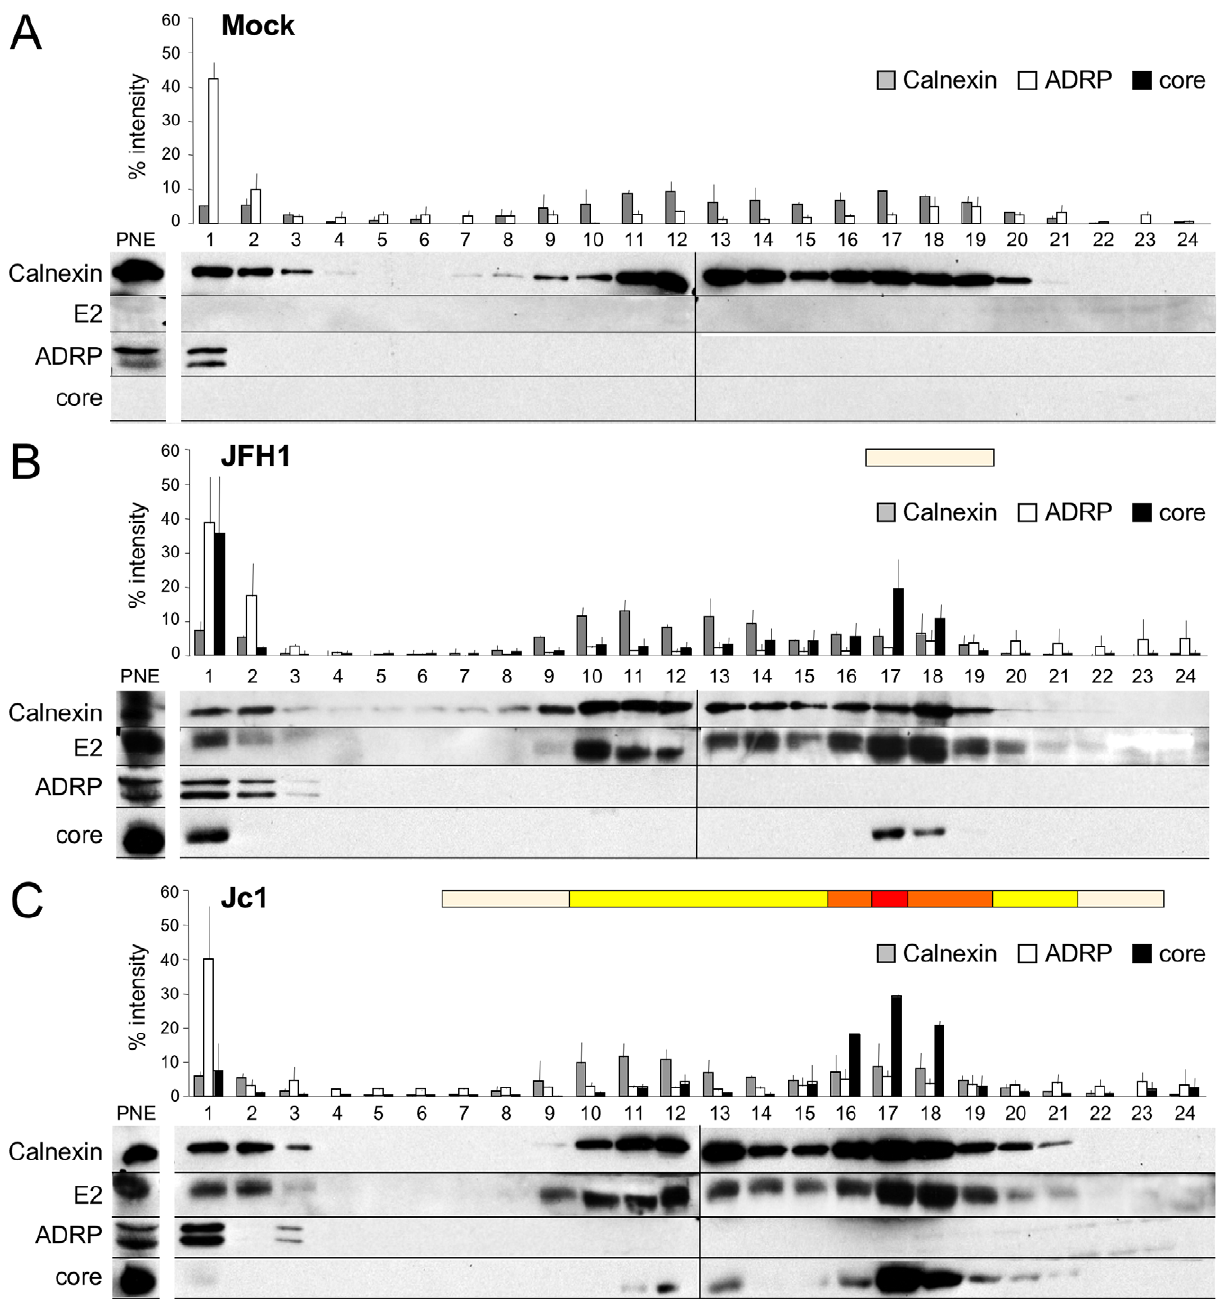
Figure 2. Characterization of JFH1 and Jc1 core localization by subcellular fractionation in HCVcc-expressing cells. Untransfected ( A ) or Huh7.5 cells transfected with RNAs from the full-length genomes of JFH1 ( B ) and Jc1 ( C ) were lysed 72 h post-transfection and ca. 2 mg of protein lysates were fractionated on an iodixanol gradient. Each fraction was analyzed by Western blotting using antibodies against Calnexin, ADRP, HCV core and E2 proteins. 1/50 of the unfractionated post-nuclear extracts (PNE) were also analyzed. The infectious titers in each fraction were determined and illustrated as different categories with titers below to 1 6 10 3 FFU/fraction (white boxes), from 1 to 3 6 10 3 FFU/fraction (yellow boxes), from 3 to 6 6 10 3 FFU/fraction (orange boxes), and titers up to 6 6 10 3 FFU/fraction (red box). maximum of 55% of infected cells at day 43 (Figure 3A, left panel), independent HCVcc long-term cultures, was in sharp difference to suggesting an adaptation of virus propagation during LTC, as the strict JFH1 core LD-localization detected at day 3 of the discussed earlier [41]. Surprisingly, when the cellular localization culture, i.e. , in over 98% of total LDs (Figure 3B, Figure 1A, 1B, of core was analyzed in HCVcc-infected LTCs, JFH1 core Figure S1). In contrast, the subcellular localization of Jc1 core displayed a predominant ER localization pattern at day 49, with remained unchanged throughout the culture period of Jc1 HCVcc some remaining associations to LDs, i.e. , in ca. 16% of total (Figure 3B) consistent with constantly high virus titers obtained LDs (Figure 3B). This pattern, which reproducibly appeared in with this chimera. No significant changes in the sizes and numbers